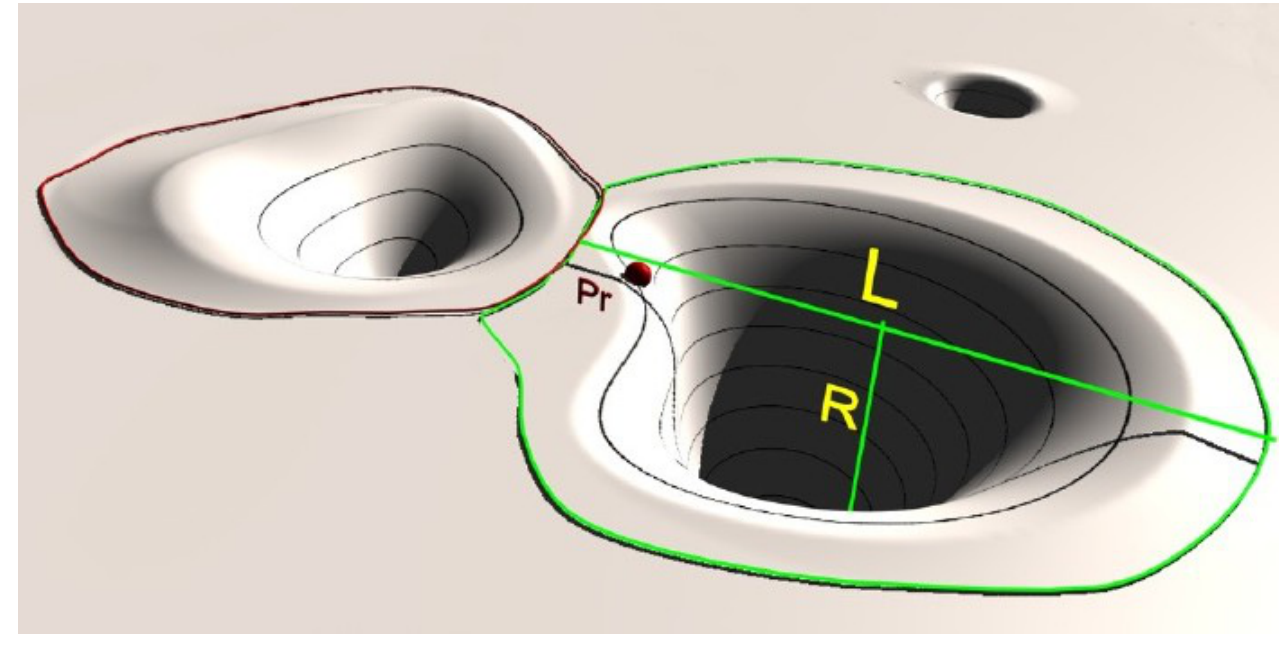
Fig. 1. Three-dimensional stability landscape with two basins of attraction showing the current position of the system (red dot) and three aspects of resilience: L = latitude, R = resistance, Pr = precariousness (adapted from Walker et al.